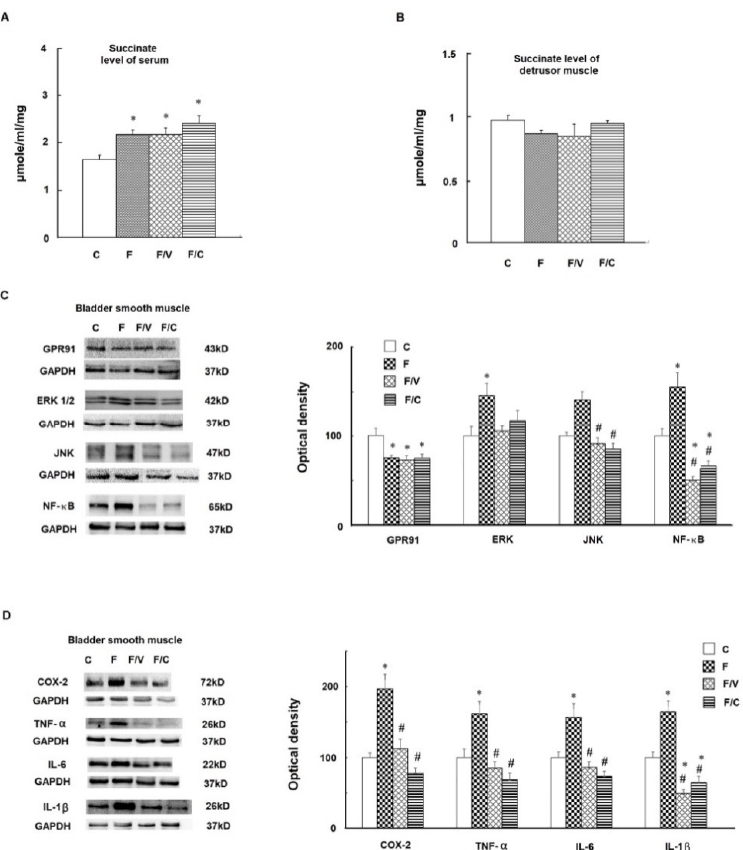
Figure 4. The content of succinate in serums and bladders and the protein expressions of GPR91 and its downstream effectors in the bladders of different groups. ( A ). Succinate levels of serums. ( B ) Succinate levels of detrusor muscles. The succinate levels were evaluated by ELISA. Western blots of GPR91, ERK 1/2, JNK, NF- κ B ( C ), COX-2, TNF- α , IL-6, and IL-1 β ( D ). Data are expressed as mean ± SEM. n = 8. * p < 0.05 versus controls and # versus fructose group.